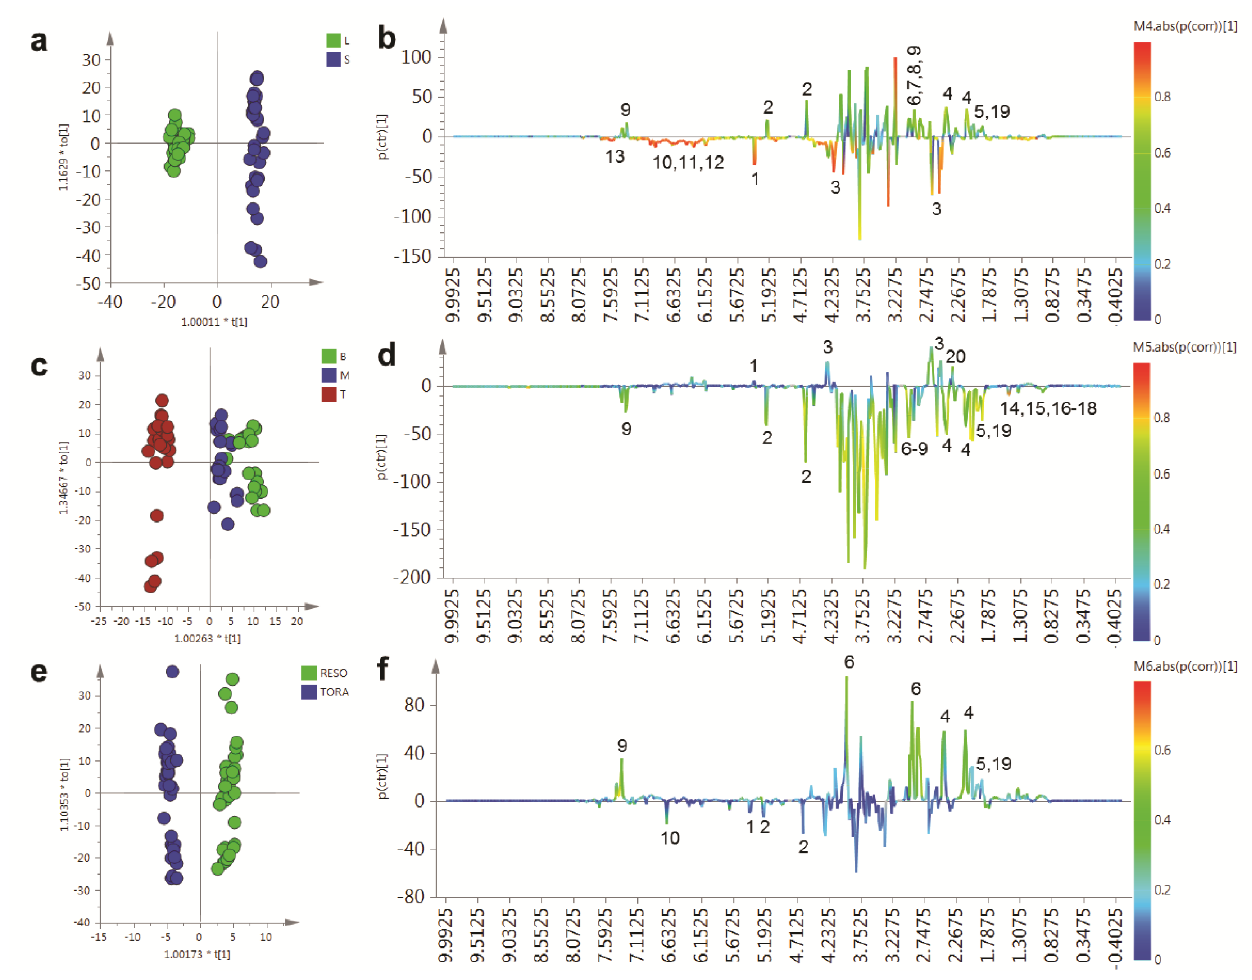
Figure 5. OPLS analysis of binned 1D 1 H-NMR data. ( a ) OPLS scores plot with Y variable as tissue type; ( b ) OPLS S-Line plot describing differences between stem (positive) and leaf (negative); ( c ) OPLS scores plot with Y variable as harvesting position; ( d ) OPLS S-Line plot describing differences between tissue harvested from the bottom of the plant (positive) and the top of the plant (negative); ( e ) OPLS scores plot with Y variable as genotype; ( f ) OPLS S-Line plot describing differences between Resolution (positive) and Tora